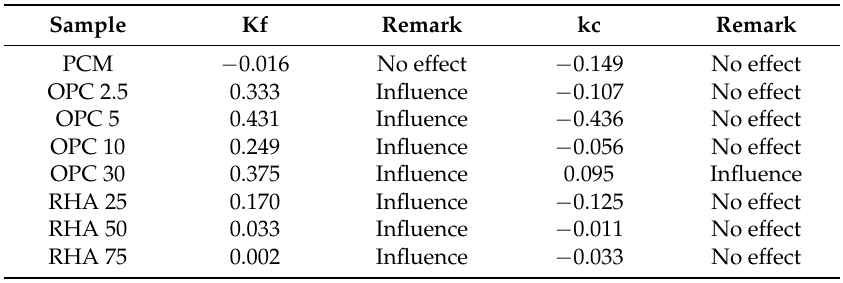
Table 4. Rate of degradation of binary and ternary mortars of alkali-activated mortars.